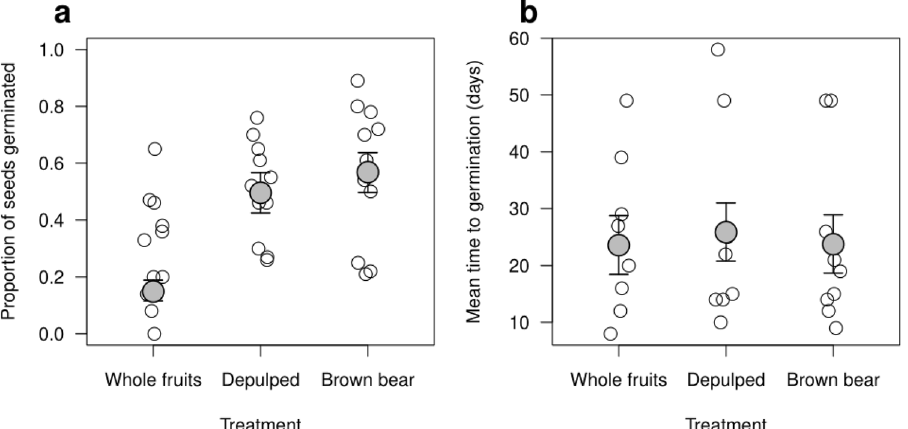
Figure 3. ( a ) Mean proportion of seeds germinated at the end of the 2-year germination experiment and ( b ) mean germination times during the first year of germination (number of days elapsed since April 1st) for 11 fleshy-fruited plant species in relation to three germination treatments (Brown bear-seeds ingested by brown bears and recovered from the scats, Depulped-manually depulped fruits and, Whole fruits-seeds embedded within the whole fruit). Grey dots and black arrows represent the predicted mean values and the standard errors, respectively. Empty dots represent the actual observed values for each fleshy-fruited plant species sown. Fleshy- fruited plant species are listed in Table